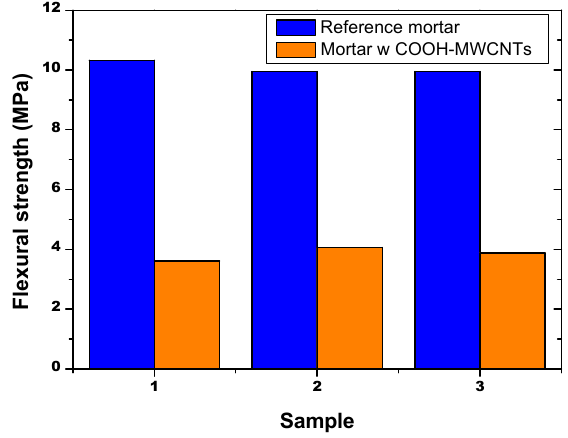
Figure 12: Flexural strength of mortars as such and with 0.5 wt% of COOH-MWCNTs